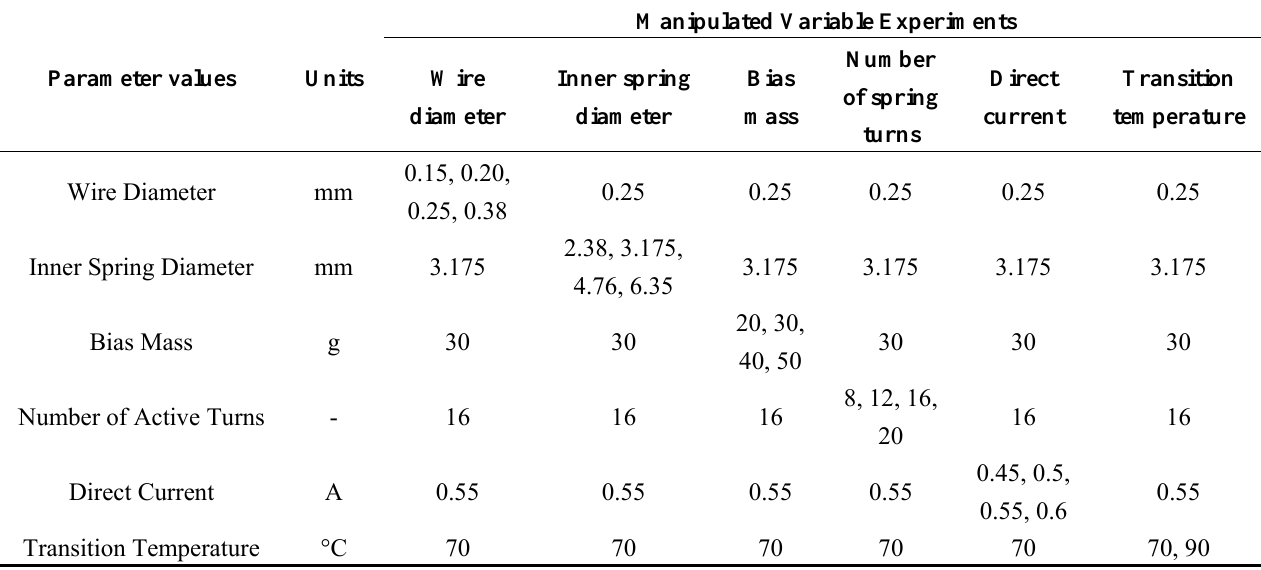
Table 1. The manipulated and controlled properties for all manipulated variable experiments. Parameter values Units